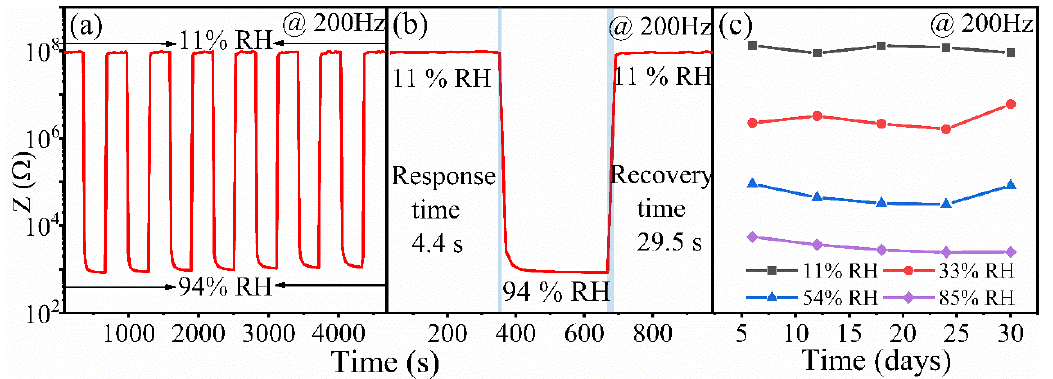
Figure 3. Humidity sensing properties of Na 0.5 Bi 0.35 TiO 3 − based sensor recorded with 200 Hz. ( a ) Re- peatability curve, ( b ) response and recovery curve, and ( c ) long-term stability curves under different humidity levels.